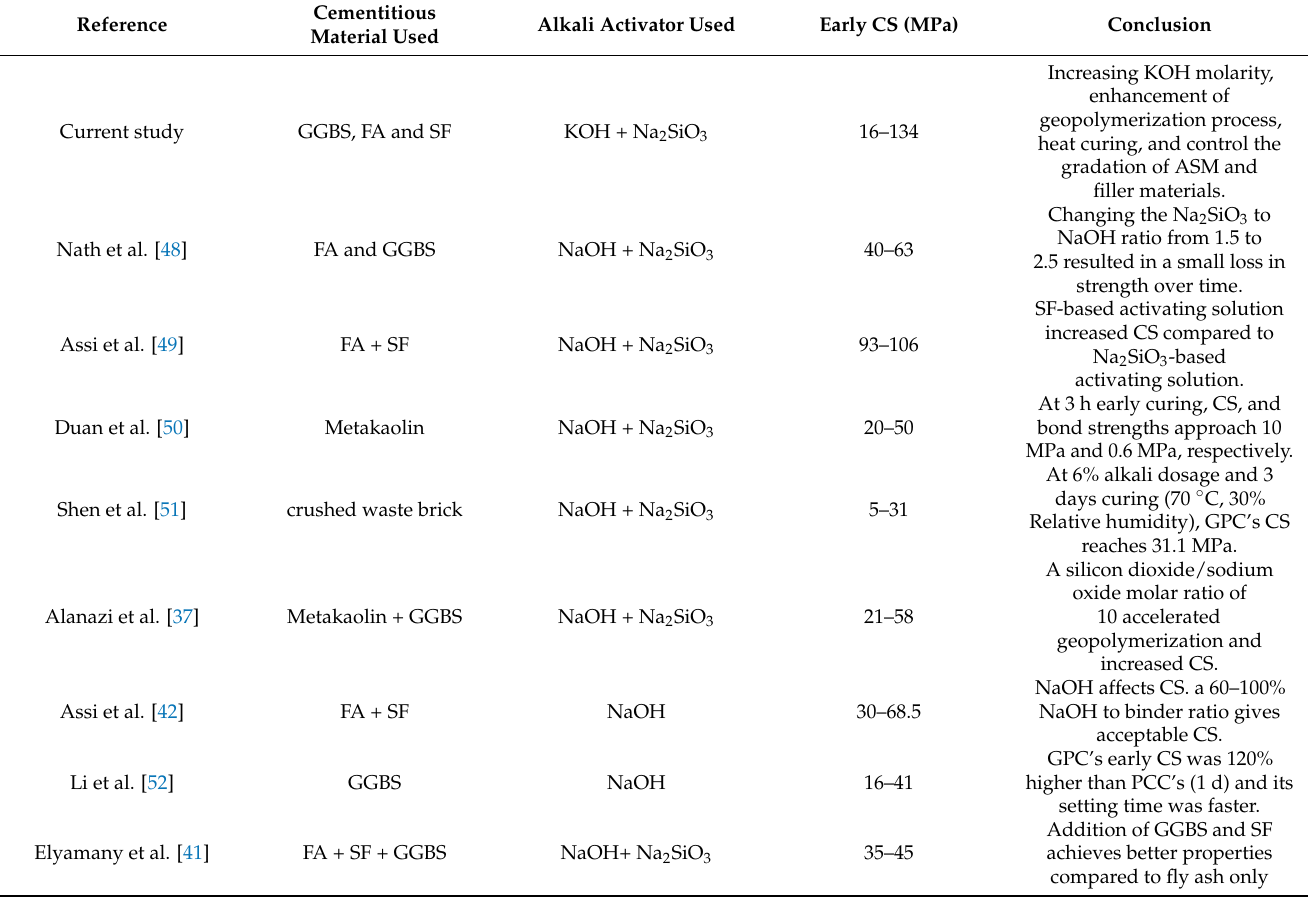
Table 5. Research summary on early compressive strength (CS) of